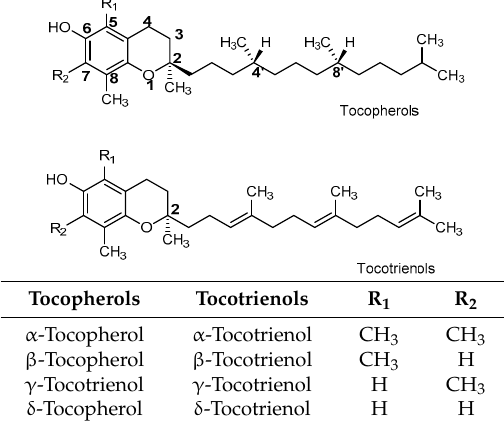
Figure 1. Structures and methyl positions of tocopherols and tocotrienols.